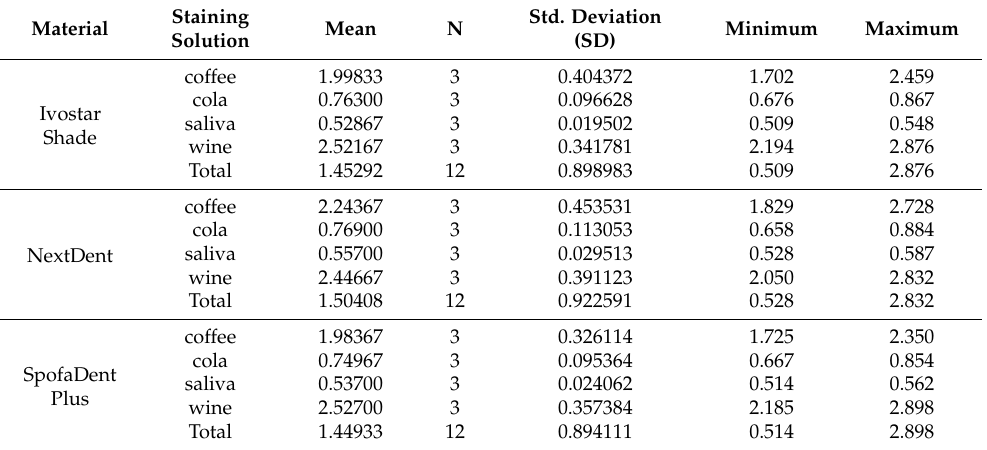
Table 7. Colour changes over time in different types of denture teeth. (Standard Deviation—SD)